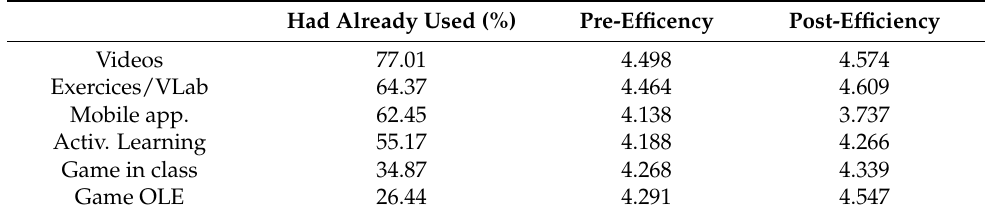
Table 7. Comparative efficiency of learning tools.